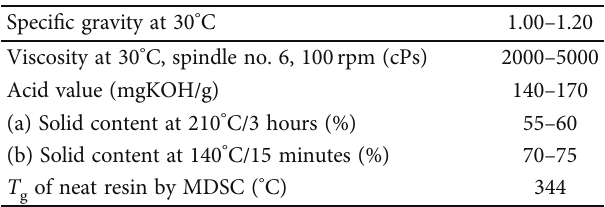
Table 2: Properties of anamide